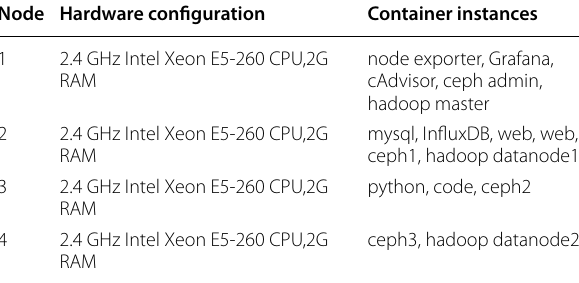
Table 2 Configuration setup table Node Hardware